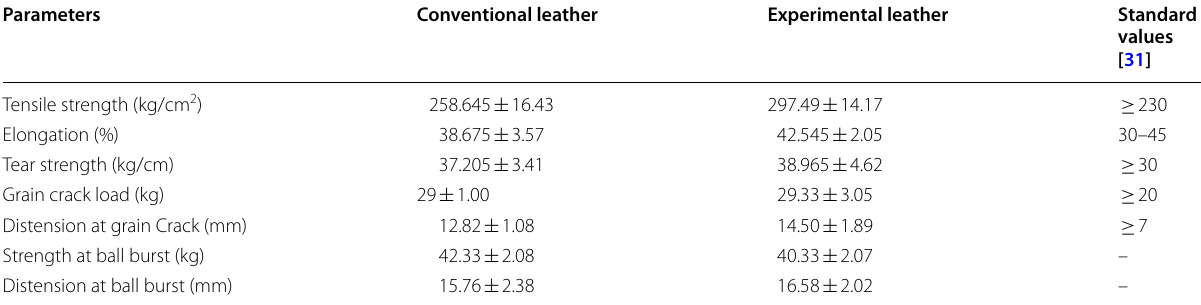
Distension at ball burst